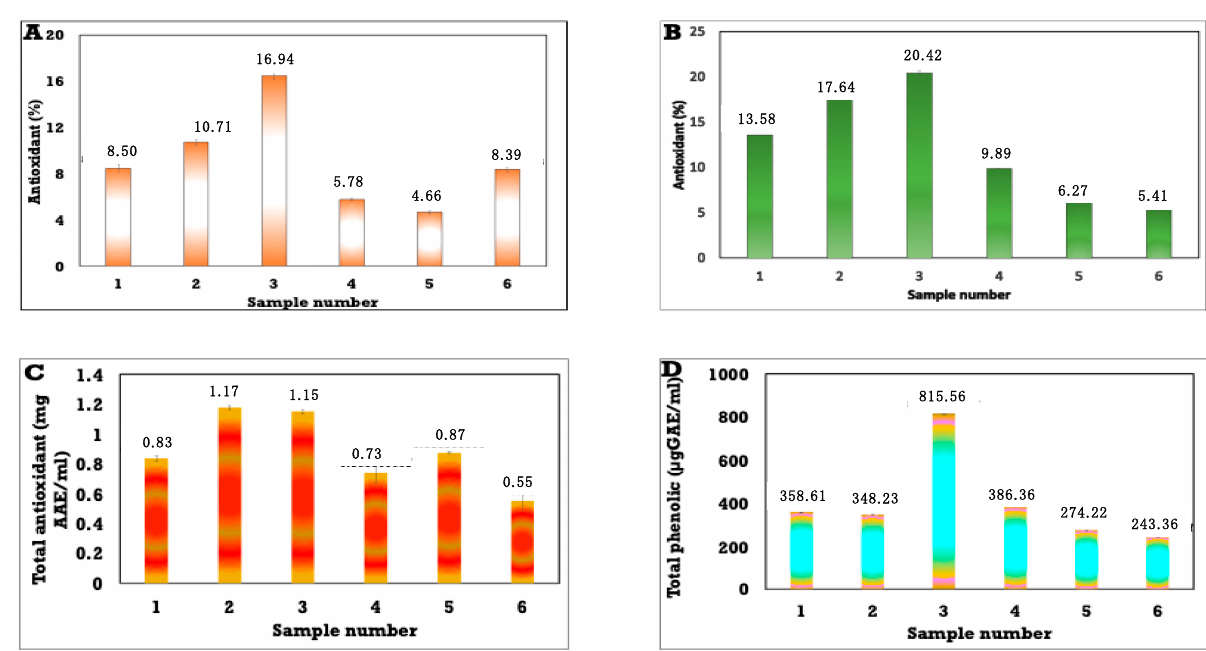
Figure 7. Antioxidant activities of different concentrations of anise oil-based nanoemulsions determined using the 2,2- Diphenyl-1-picrylhydrazyl assay ( A ), 2,2 ′ -Azinobis-3-ethylbenzothiazoline-6-sulfonic acid assay ( B ), total antioxidants ( C ), and total phenolics ( D ).